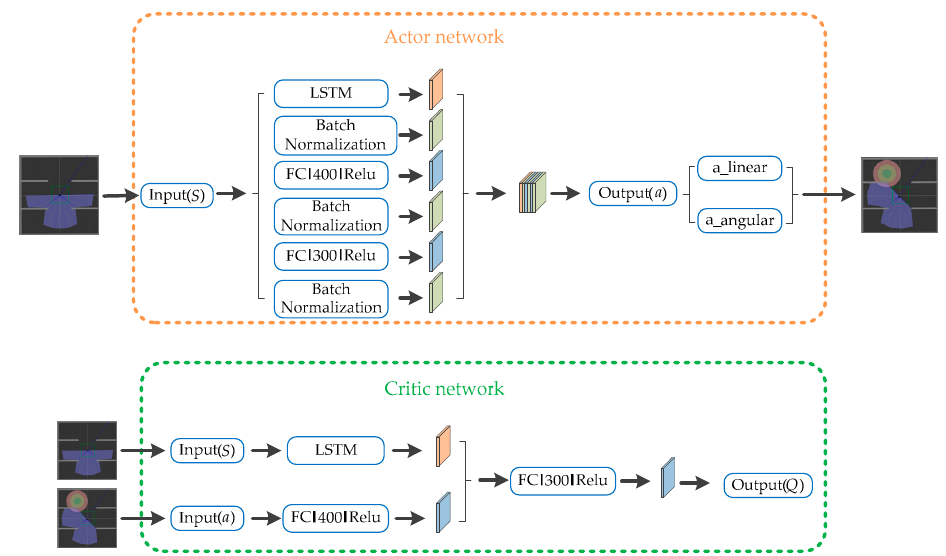
Figure 3. Our designed LSTM-DDPG network structure.